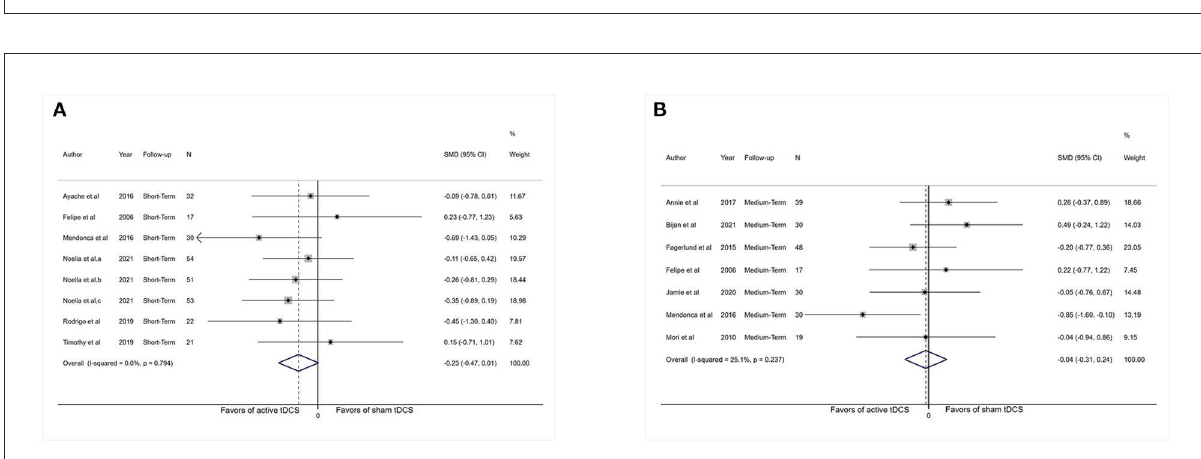
FIGURE5 Forest plot showing overall effect sizes (Hedges’ g) of real tDCS on anxiety within studies. These plots show the pooled SMD (large diamond shape) and I 2 resulting from the meta-analysis. (A) Anxiety scores from short-term data. (B) Anxiety scores from medium-term data. CI, confidence interval; SMD, standard mean difference; tDCS, transcranial direct current stimulation; a, motor cortex; b, dorsolateral prefrontal cortex; c, operculo-insular